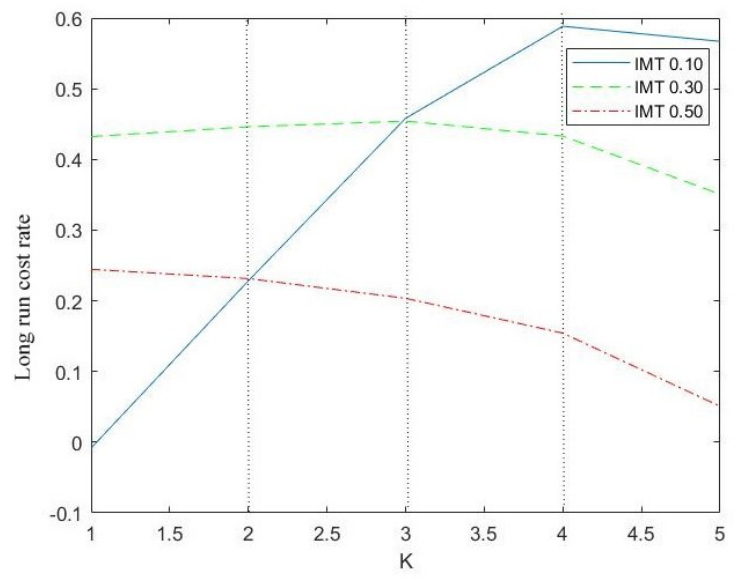
Figure 6. The long-run cost rate versus K for µ I = 0.10, µ I = 0.30, µ I =